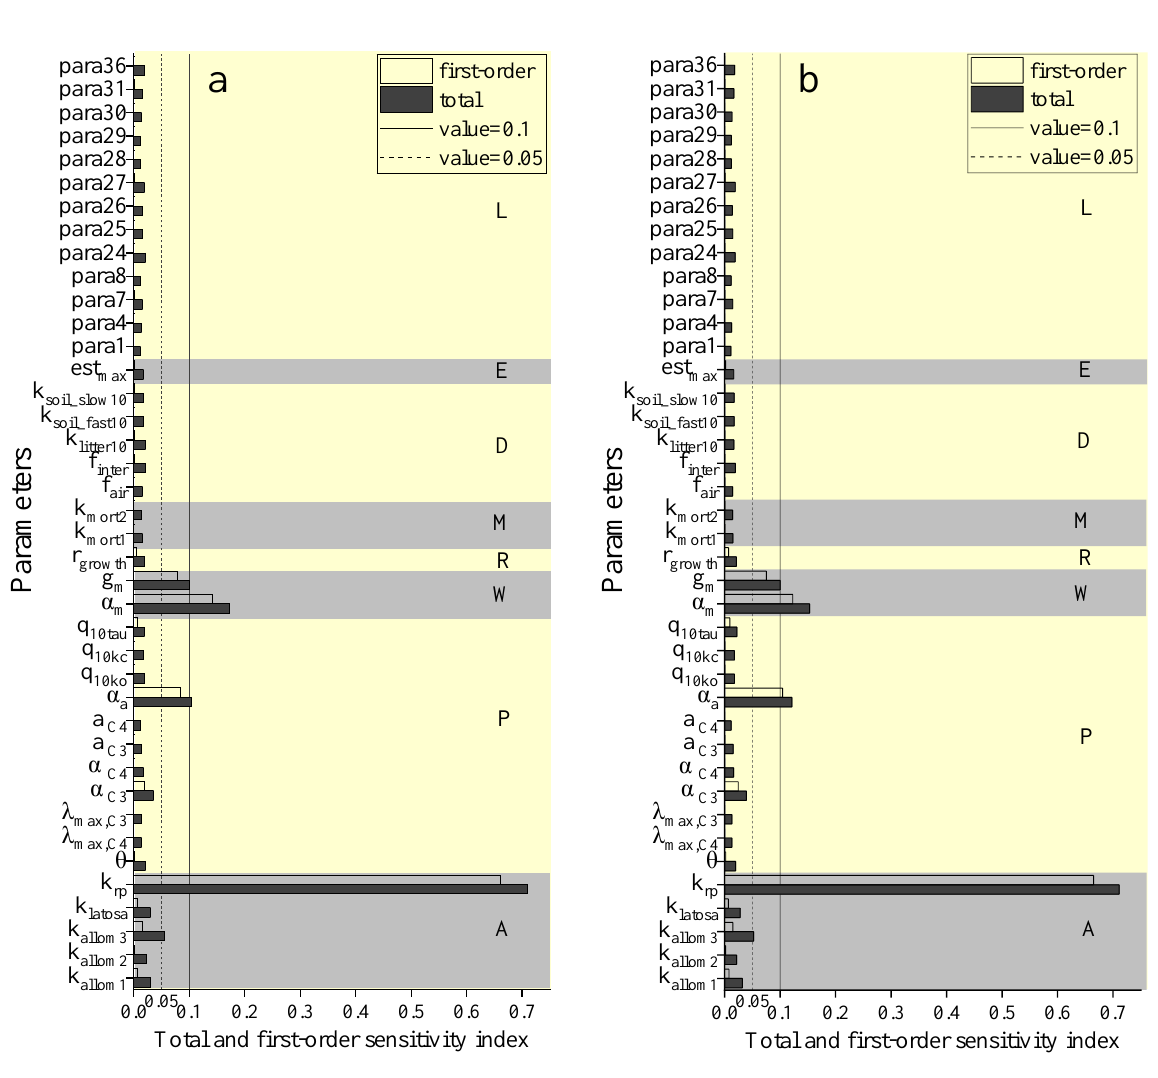
Table 2. Sensitivity analysis rankings of the LPJ model parameters for the NPP output response based on the EFAST and Morris method.